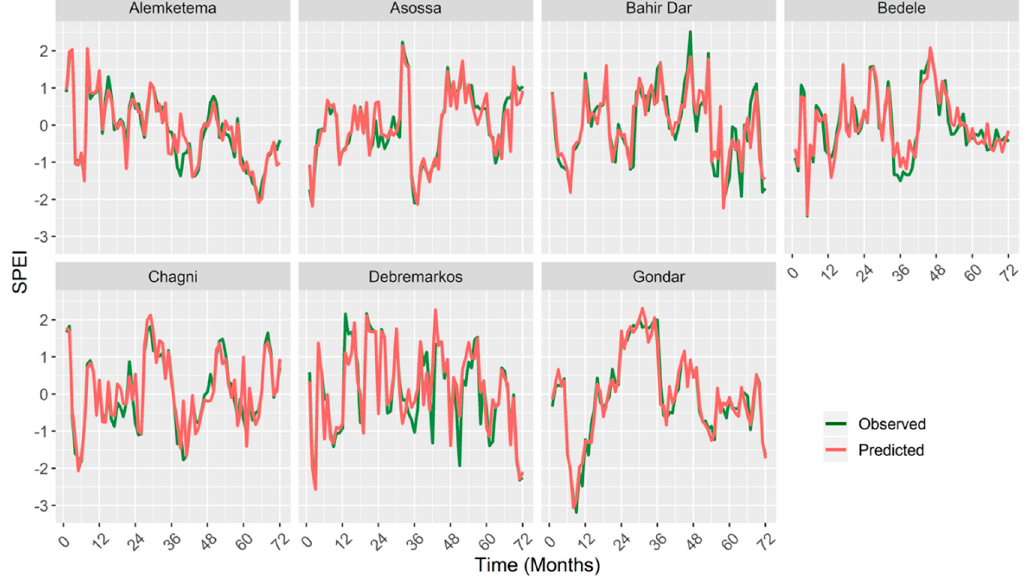
Figure 7. Observed and predicted SPEI 12 values using the ANN model.